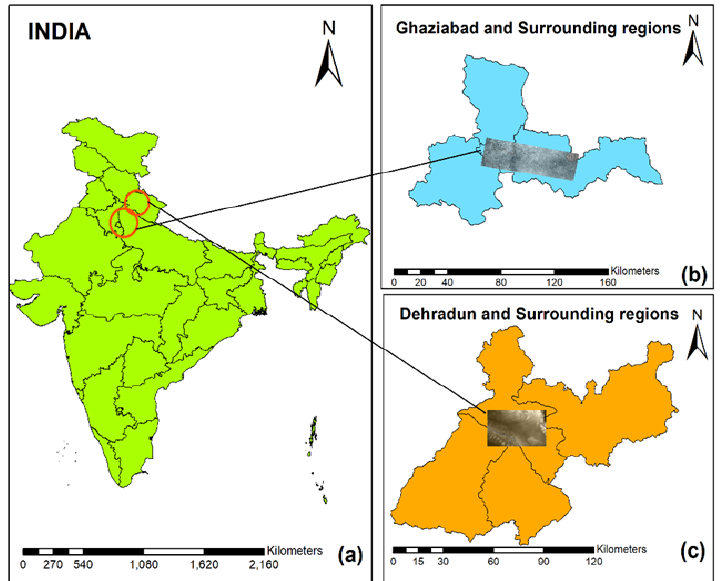
Figure 1. Study Area Map with overlay of DEMs to show the extent of study areas: ( a ) India; ( b ) Study Area 1: Ghaziabad and Surrounding regions; ( c ) Study Area 2: Dehradun and Surrounding